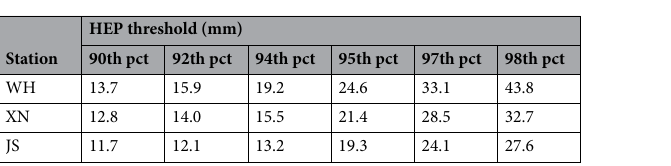
Figure 6. Diurnal variations of precipitation intensity obtained from summer hourly precipitation data of ( a ) WH, ( b ) XN and ( c ) JS stations in each year of 2007–2019.